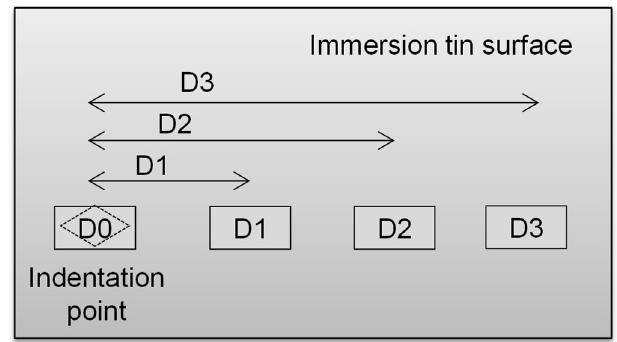
Figure 7. A schematic diagram to indicate the position on the immersion tin surface to be observed by FESEM.